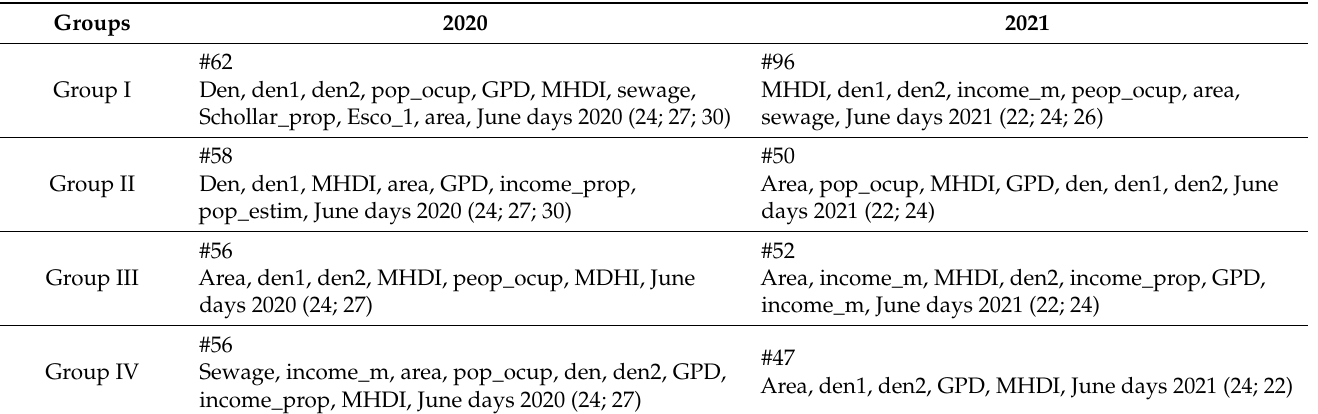
Table 11. Criteria used on decision rules for groups in 2020 and